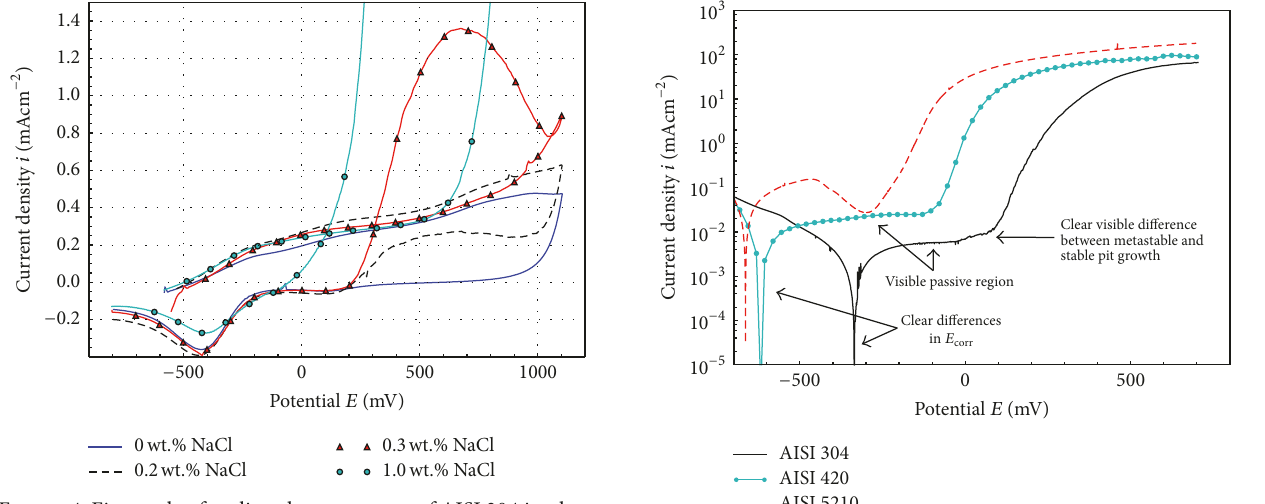
Figure 4: First cycle of cyclic voltammograms of AISI 304 in phos- phate buffer with different contents of NaCl. The CVs are recorded from − 800mV to 1100mV with a scan velocity of 100mVs −1 . All potentials are measured against a Ag/AgCl electrode.